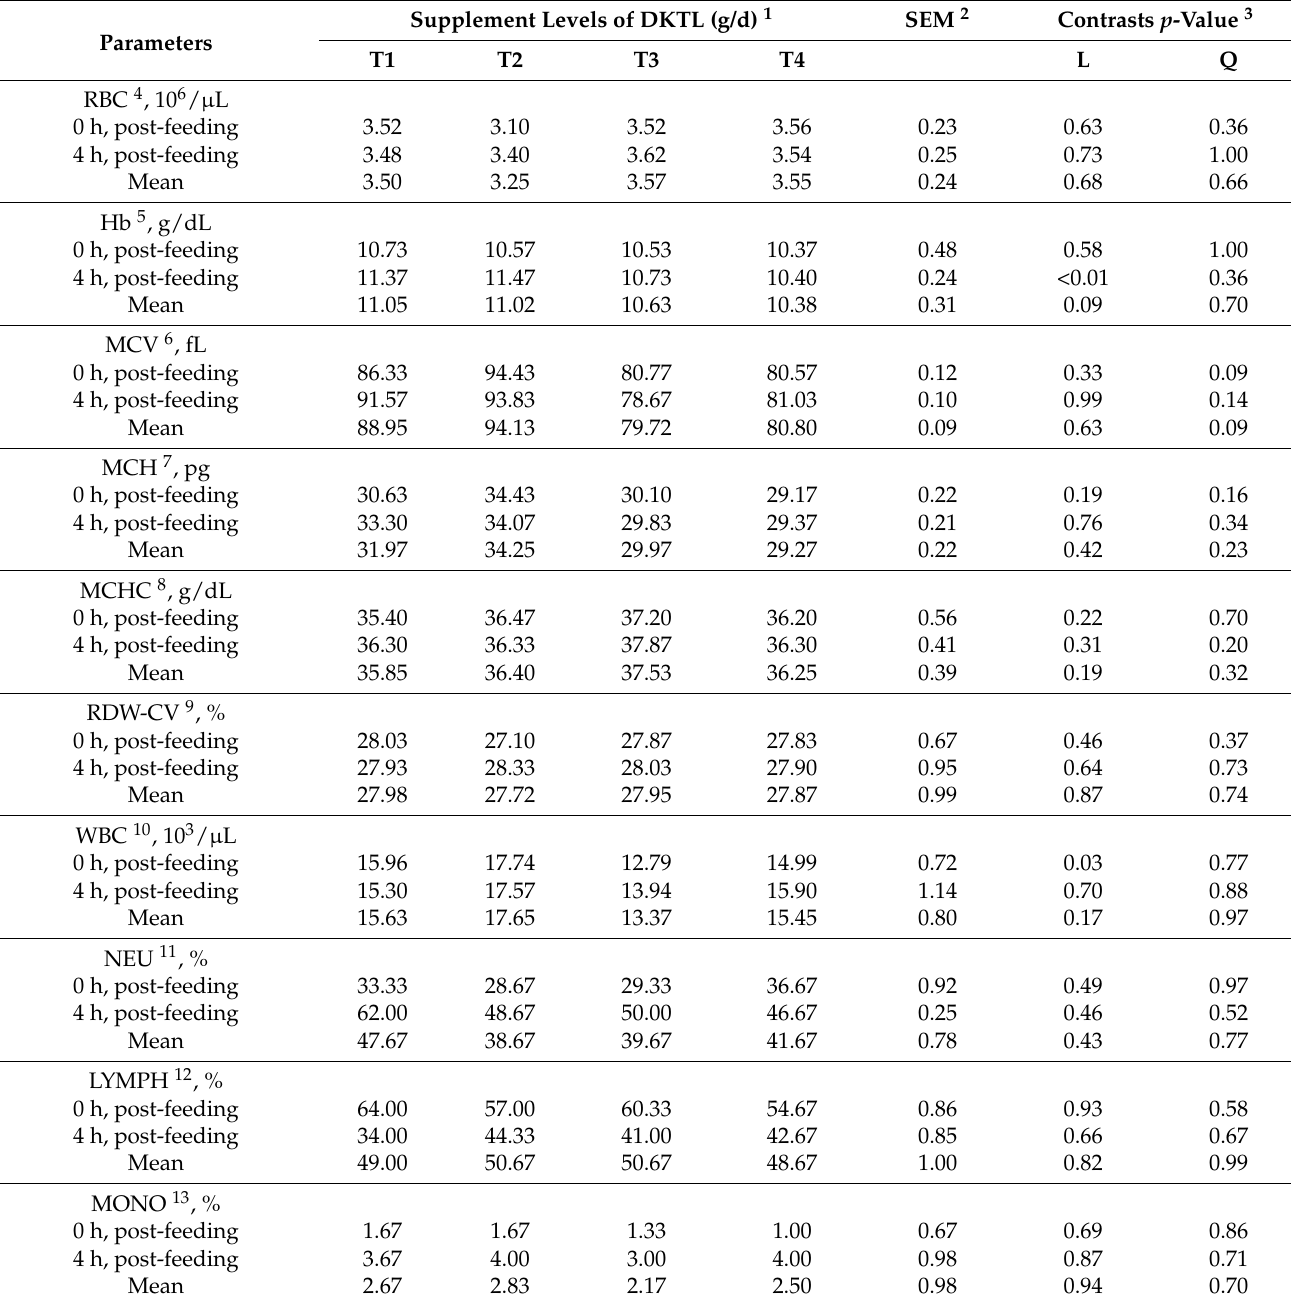
(Table 10) ( p > 0.05). Hematology indicators such as SGOT, Alp, Hb, and Plt were decreased with DKLT supplementation, but WBC was raised ( p < 0.05). Table 9. Effects of Kratom leaves supplement on hematology parameters of fattening goats